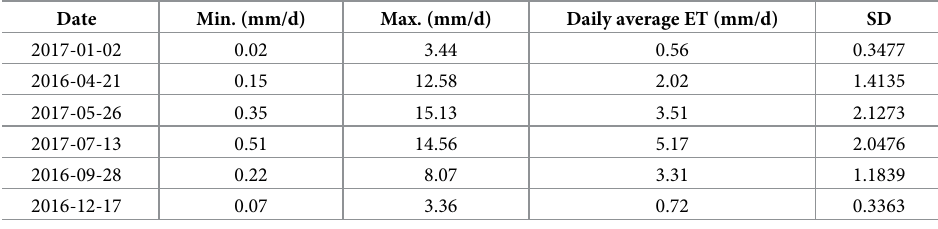
Table 1. Daily average evapotranspiration in the study